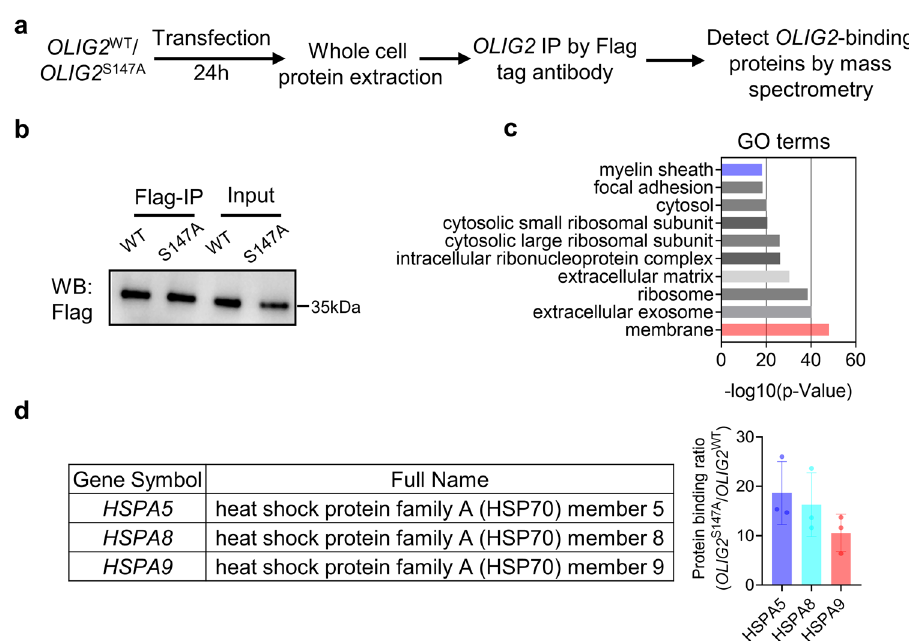
Fig. 5 Proteomic analysis identi fi ed proteins that differentially bound to OLIG2 S147A and OLIG2 WT smRNA. a Schematic of the proteomic analysis protocol using hiPSC1-derived NPCs transfected with OLIG2 S147A or OLIG2 WT smRNA. b Western blot analysis of the OLIG2 S147A and OLIG2 WT proteins pulled down with a Flag tag. c Proteins exhibiting differential binding to OLIG2 S147A and OLIG2 WT were analyzed using the DAVID bioinformatics database to identify proteins involved in the myelin sheath pathway. d The OLIG2 S147A / OLIG2 WT binding ratio of HSP70 complex components (HSPA5, HSPA8 and HSPA9) involved in the myelin sheath